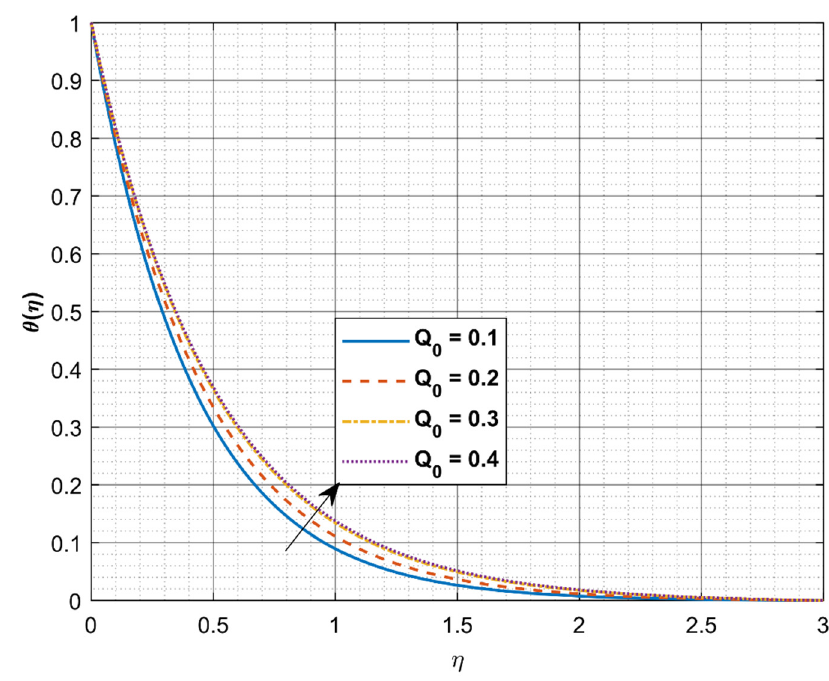
θη Q on ( ) . 0 R on d